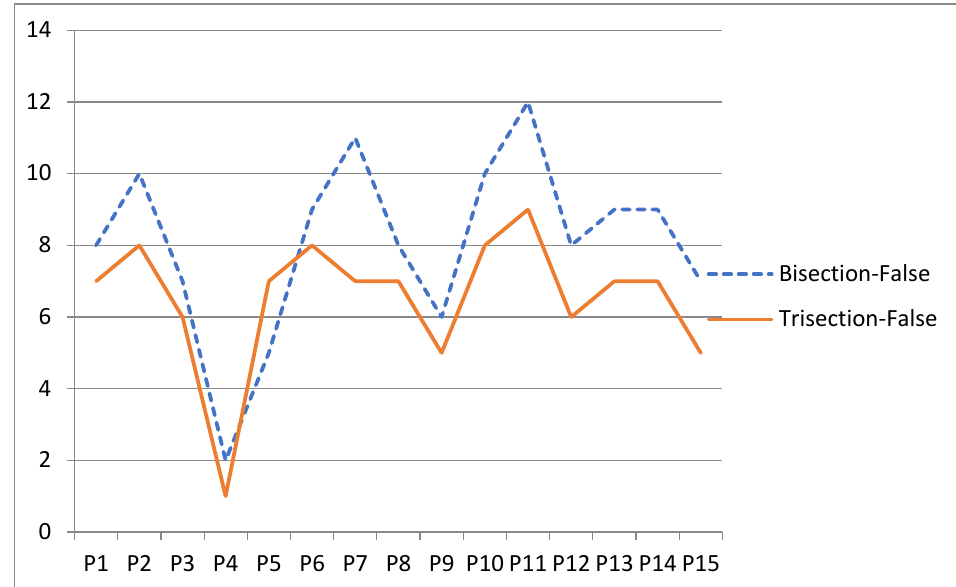
Figure 4. A comparison among 7 methods on 15 problems according to the number of iterations.